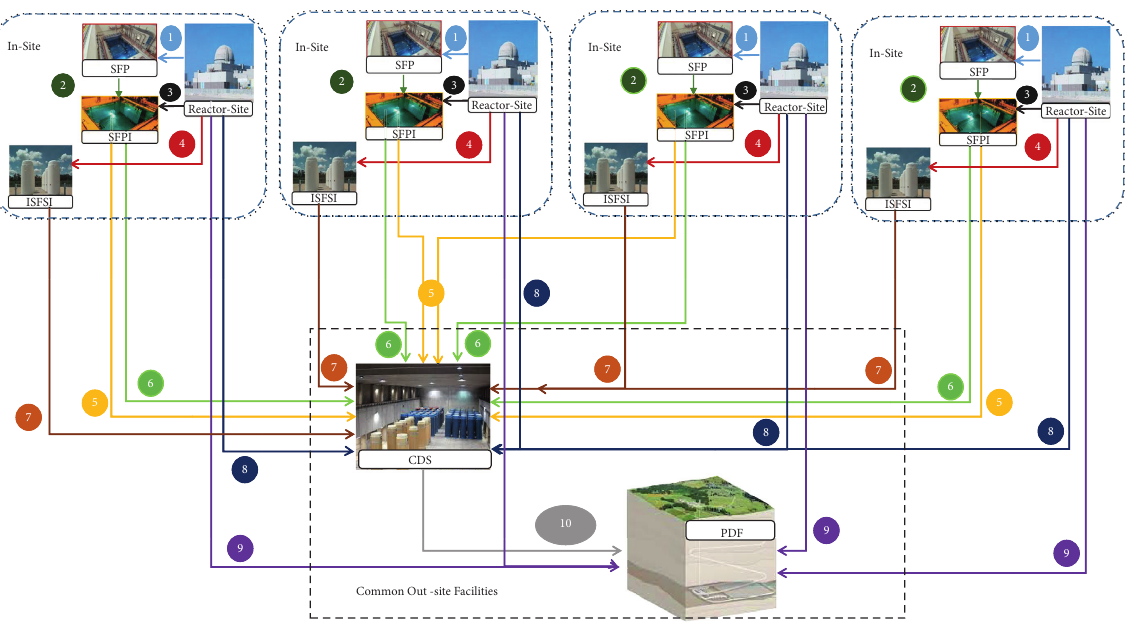
Figure 3: Chart of possible spent fuel management strategies for the Barakah site.